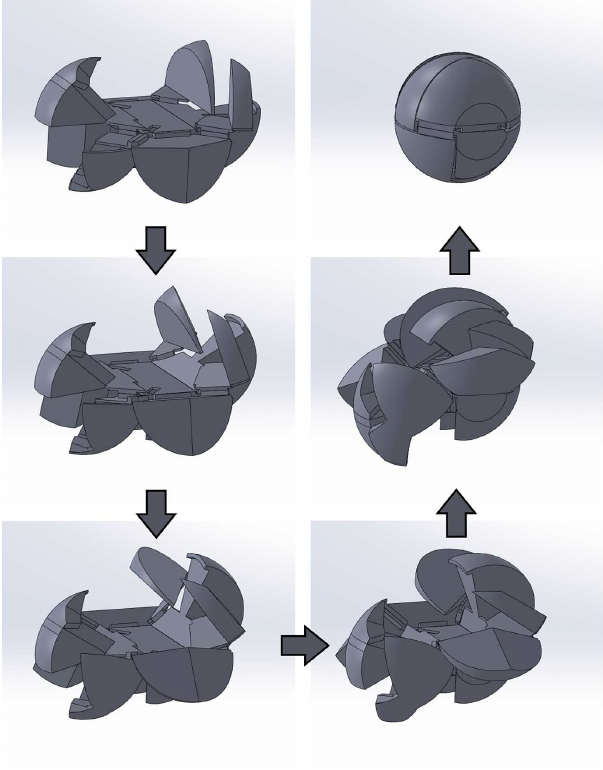
Figure 8. A kinematic simulation model of how panel geometry can vary, in this case to form a sphere.